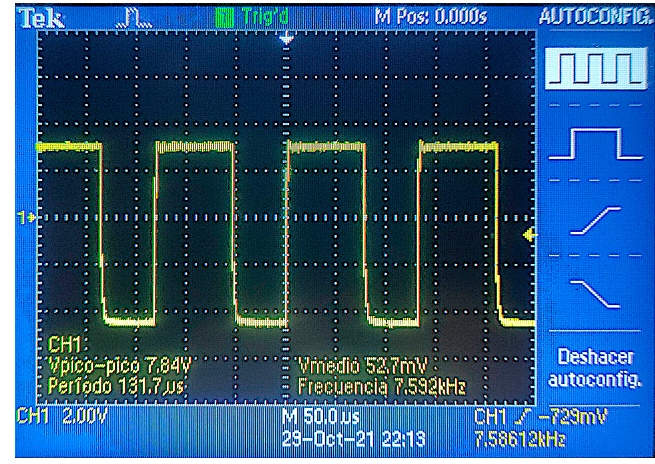
Figure 9. Example of signal obtained in Output 1.